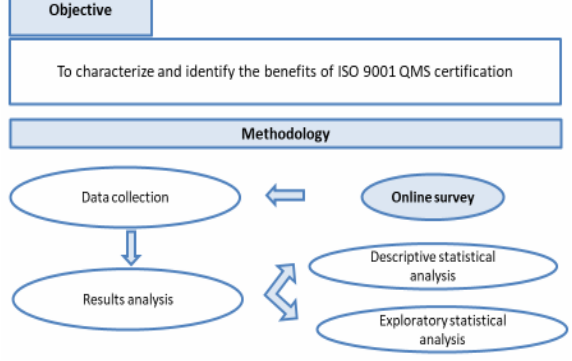
Figure 1. Research